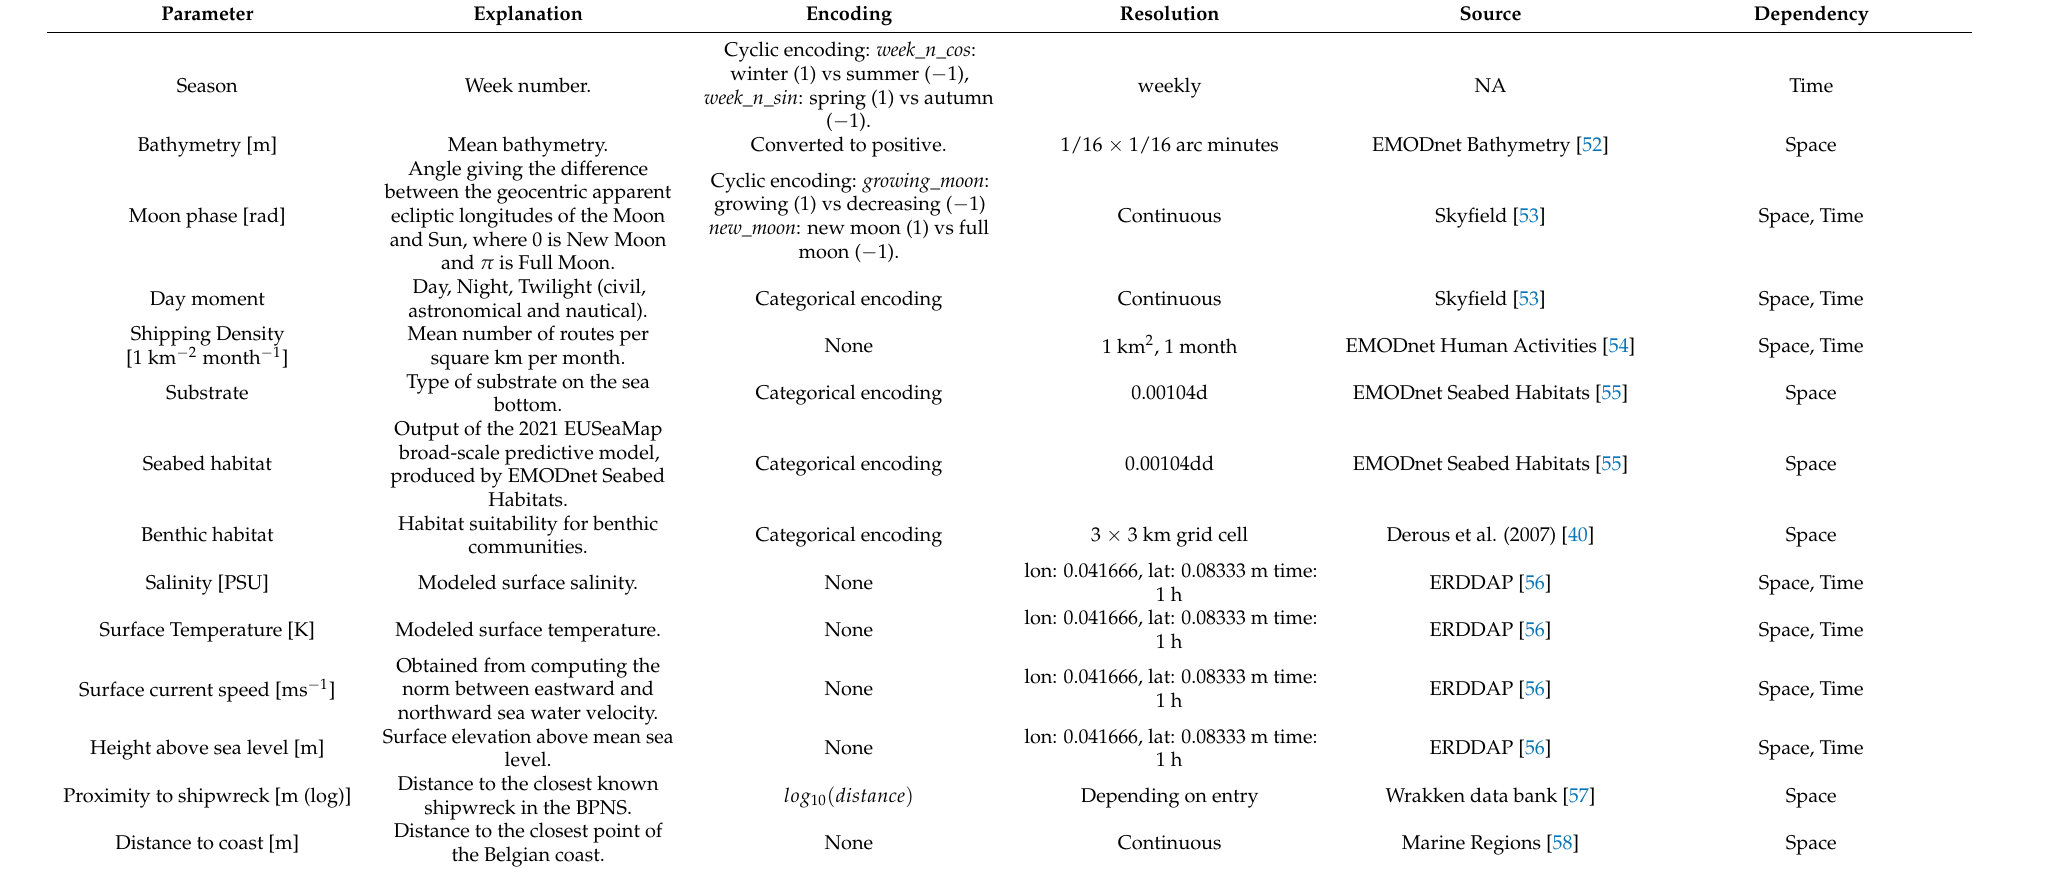
Table 1. Summary of the all the available environmental